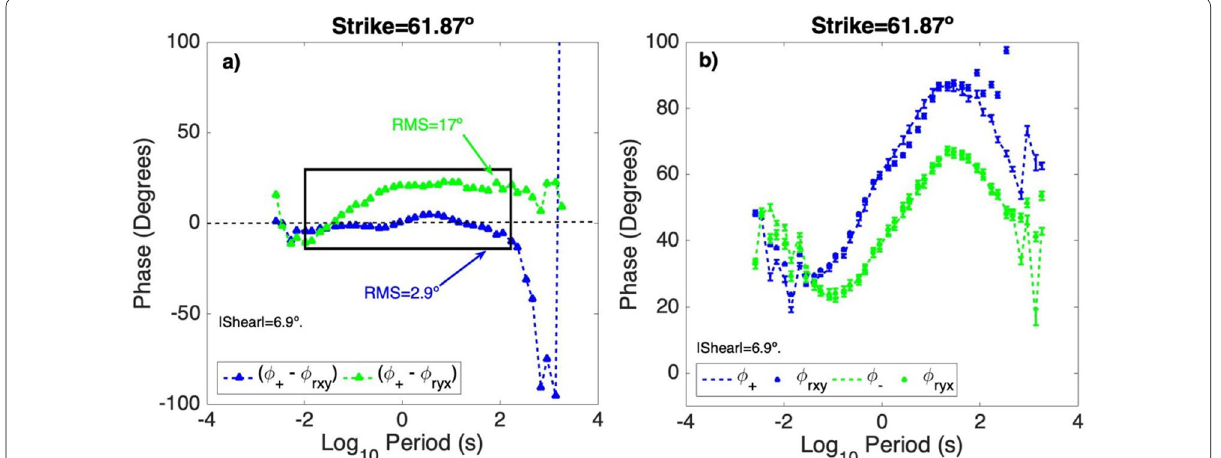
Fig. 15 a Differences of ∅ with the phases of Z Rxy and Z Ryx . The values of RMS are computed for data within the black rectangle. b Explicit + comparison of phases for a strike of 61.87° assuming that ∅ is associated with the phase of Z +